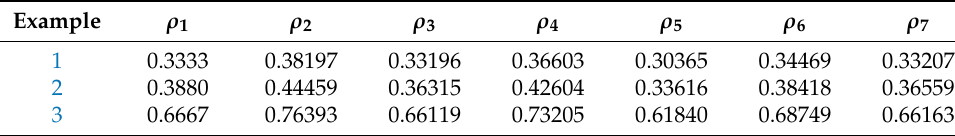
Table 1. The parameters ρ i of the Examples 1–3.